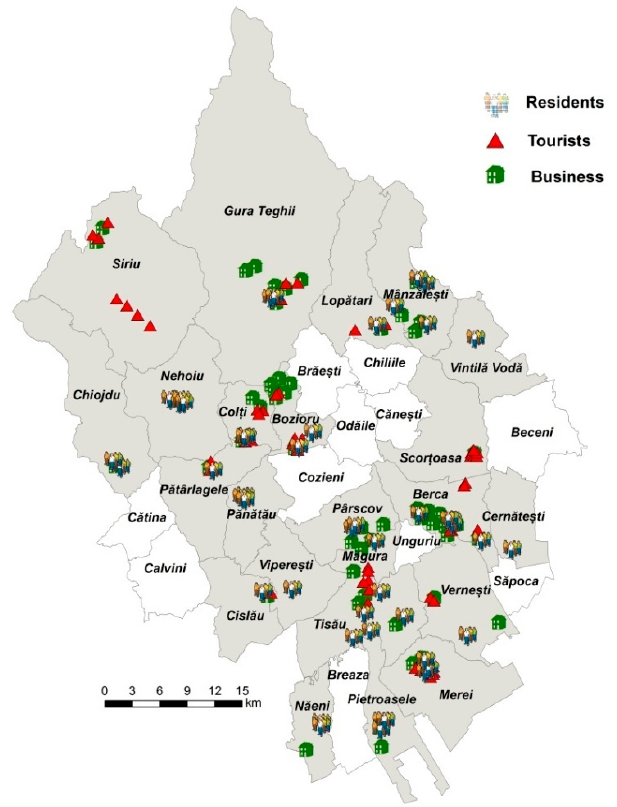
Figure 7. The spatial coverage of the study area by the field campaigns.